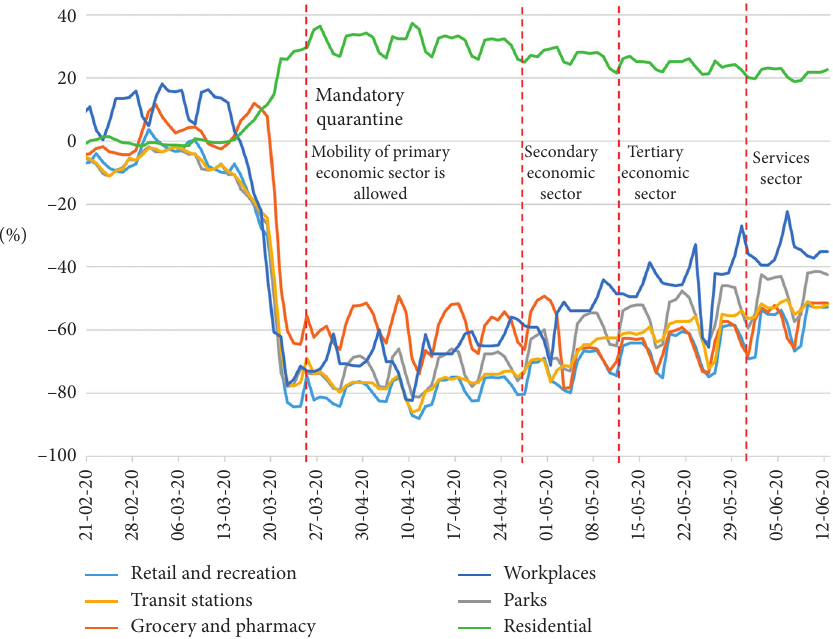
Figure 5: Activity times based on the mobility report for